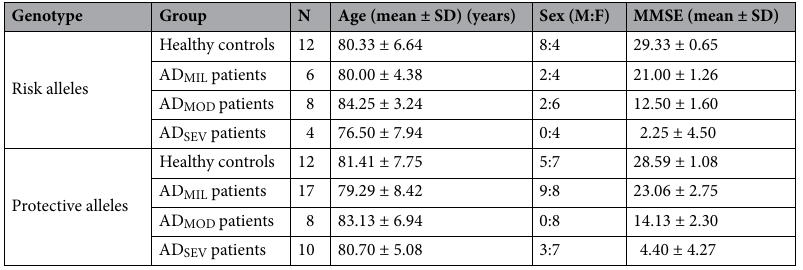
Table 1. Demographic data. SD, standard deviation; M, male; F, female; AD MIL , mild AD; AD MOD , moderate AD; AD SEV , severe AD; MMSE, Mini-Mental State Examination